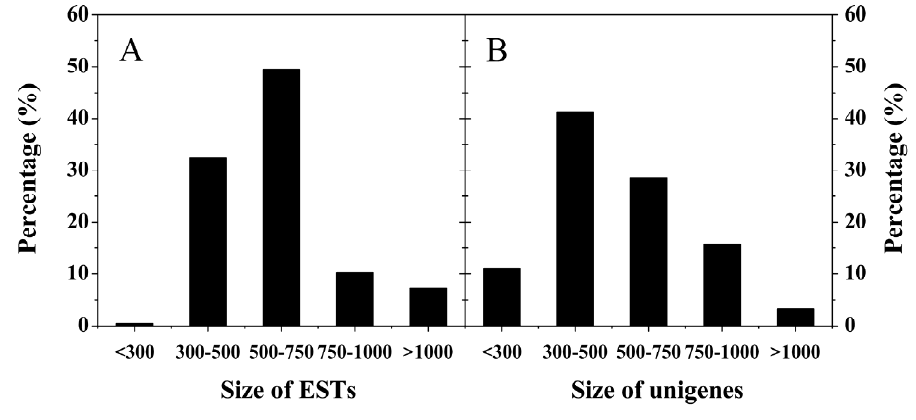
Figure 2. Distribution of the size of ESTs ( A ) and unigenes ( B ) of “Biqi” fruit on the basis of sequencing of 2000 recombinant